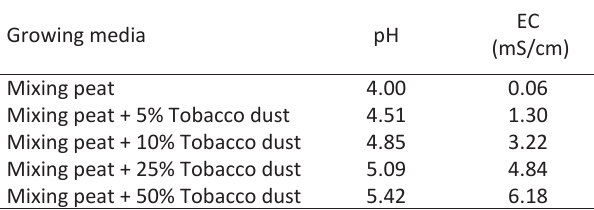
Table 2 - pH and EC (mS/cm) values of growing media after mixing peat with tobacco dust at 0 (control), 5, 10,